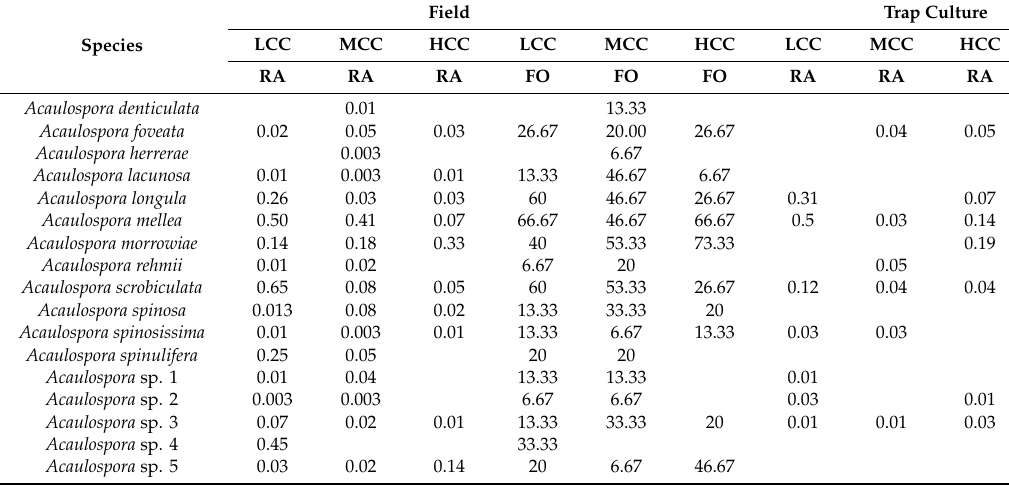
Table 4. Relative abundance (RA) and frequency of occurrence (FO) of AMF species in the field and soil trap cultures in three areas with a clay gradient (LCC: Low Clay Content, MCC: Medium Clay Content, HCC: High Clay